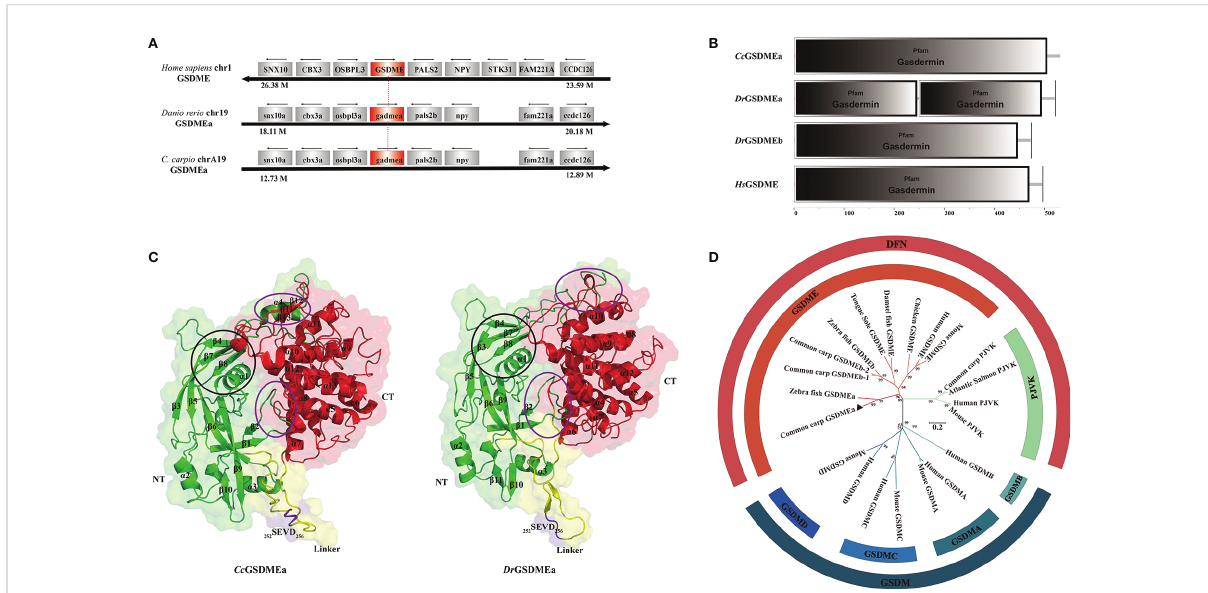
FIGURE 1 Structural feature and phylogenetic evolution of Cc GSDMEa. (A) Gene synteny and chromosomal location analysis of CcGSDMEa . The genes adjacent to GSDME loci on human chromosome 1, zebra fi sh chromosome 19, common carp chromosome A19 are shown. Arrows indicate gene orientation. The small arrows above the gene indicate the direction in which the gene is transcribed. (B) Structure domains of Cc GSDMEa, Dr GSDMEa/b, and Hs GSDME predicted by SMART. (C) The tertiary structures of Cc GSDMEa and Dr GSDMEa modeled by I-TASSER. The NT domains and CT domains are colored green and red, respectively. The motifs of tetrapeptide 252 SEVD 256 speci fi cally recognized by caspases are marked in purple, and the linker regions are labeled in yellow. Secondary structure element a -helices and b -strands are indicated in images. The inter-domain interfaces are highlighted by purple ellipses. The a 1, b 3, b 4, b 7 and b 8 marked by the black circle form the structure of the membrane inserted N-terminal domain. (D) Phylogenetic relationships of GSDM family members. The phylogenetic tree was constructed by MEGA (version 7.0) using the neighbor-joining method. The reliability of each node was estimated by bootstrap test with 1000 replications. The accession numbers of selected GSDM protein sequences from the National Center for Biotechnology Information Reference Sequence database (http://www.ncbi.nlm.nih.gov/RefSeq/) are shown in Table